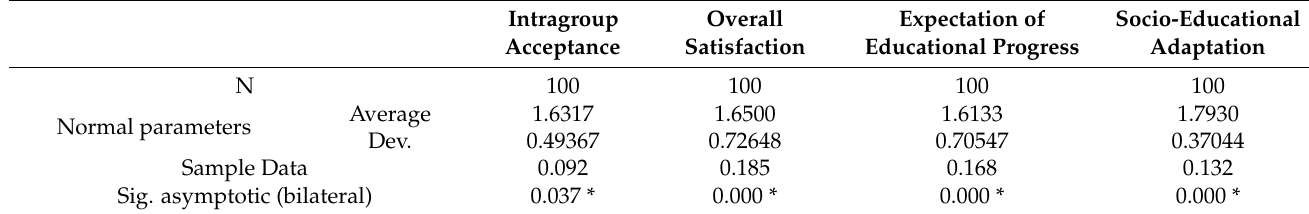
Table 4. Kolmogorov-Smirnov normality test of a